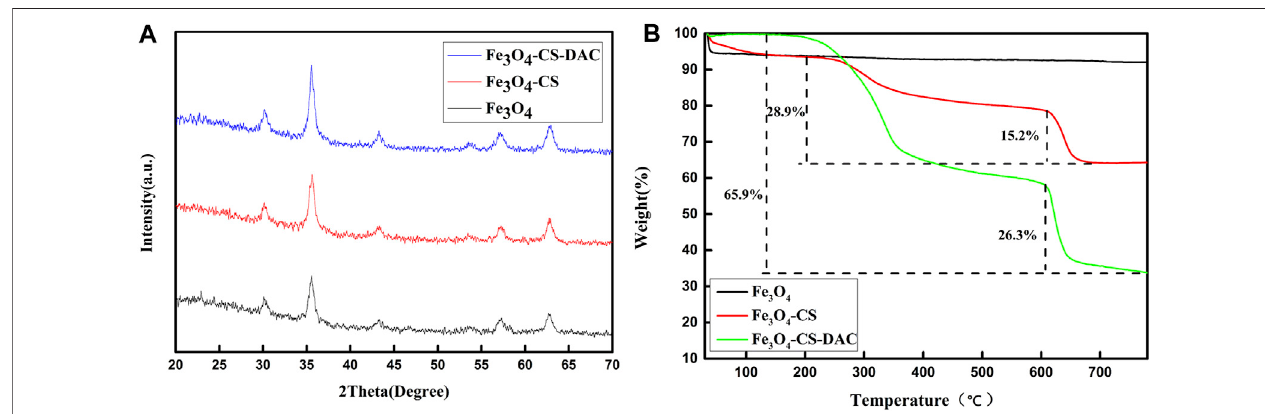
FIGURE 3 | X-ray diffraction characterization (A) and thermogravimetric analysis curve (B) of support.